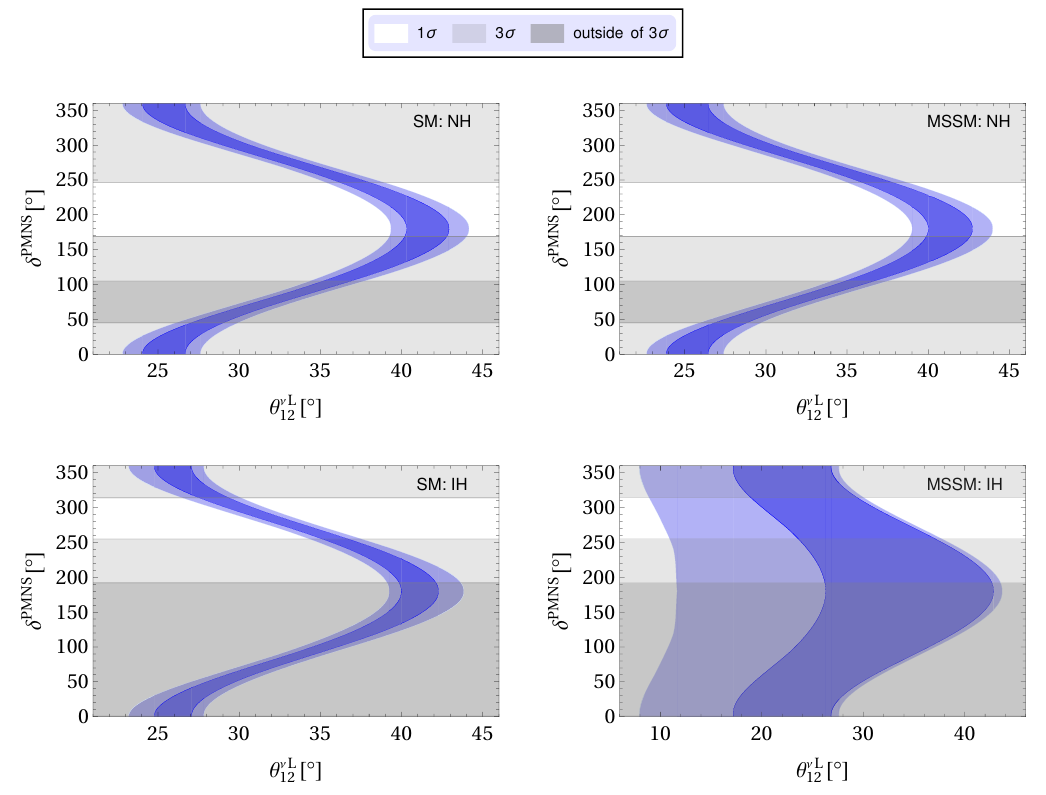
Figure 3 . Predictions for the 1 σ and 2 σ HPD intervals of the PMNS Dirac CP phase δ PMNS as a function of θ ν including running effects. The experimental 1 σ and 3 σ ranges are represented by 12 white and light gray regions, respectively. Left: SM. Right: MSSM. Top: NH. Bottom: IH.